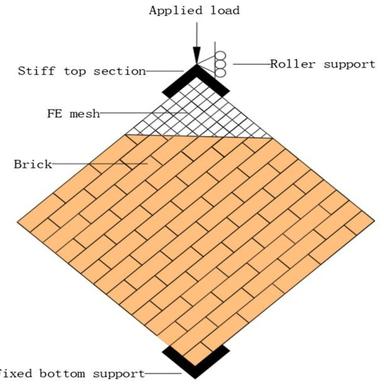
FE model (macro-modelling strategy) for strengthened masonry panel subjected to diagonal compression loading.